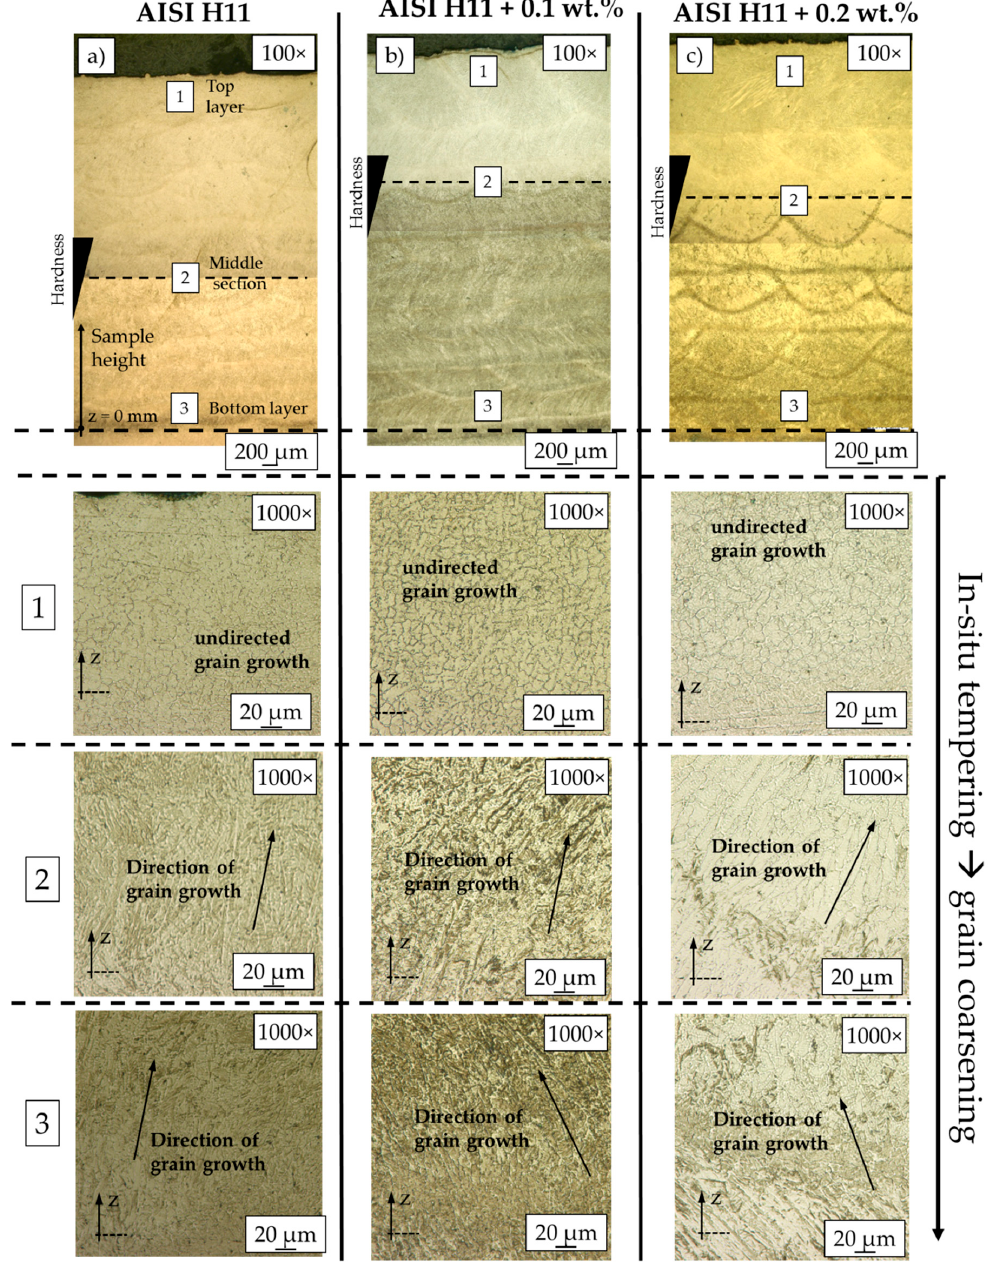
Figure 11. Microscope images of the local microstructure (top layer, middle section and bottom layer) of a ten-layered sample made out of ( a ) pure AISI H11, ( b ) AISI H11 + 0.1 wt. % and ( c ) H11 + 0.2 wt. % carbon black nanoparticles (V2A etchant; process parameters: P = 600 W, (cid:1865)(cid:4662) = 2.75 g/min, f rate = 400 mm/min).